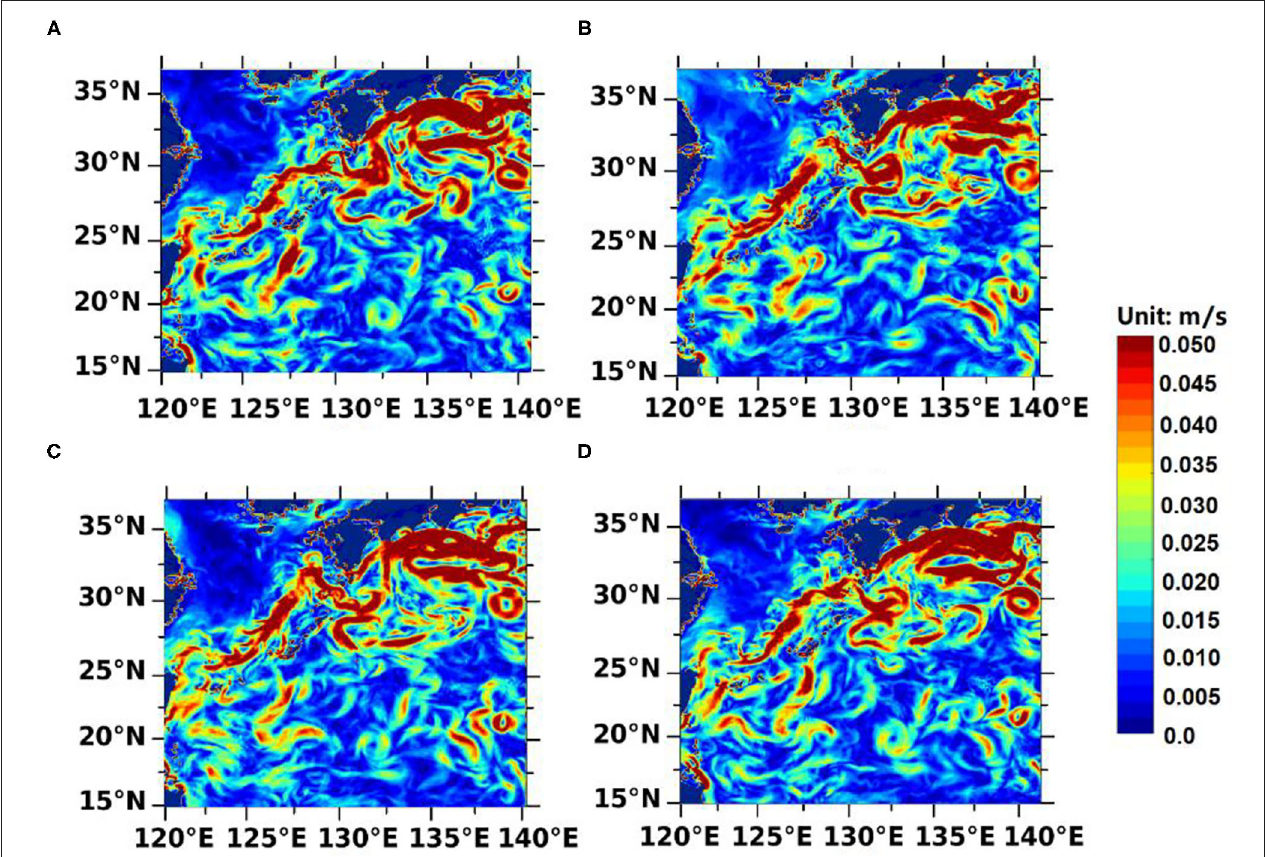
FIGURE 5 | (A) The absolute geostrophic velocity derived from Figure 4A , the original SSH; (B) the absolute geostrophic velocity from Figure 4C (the AnDA method); (C) the absolute geostrophic velocity from Figure 4D (the PredNet method); (D) the absolute geostrophic velocity from Figure 4E (the Mapping-PNN